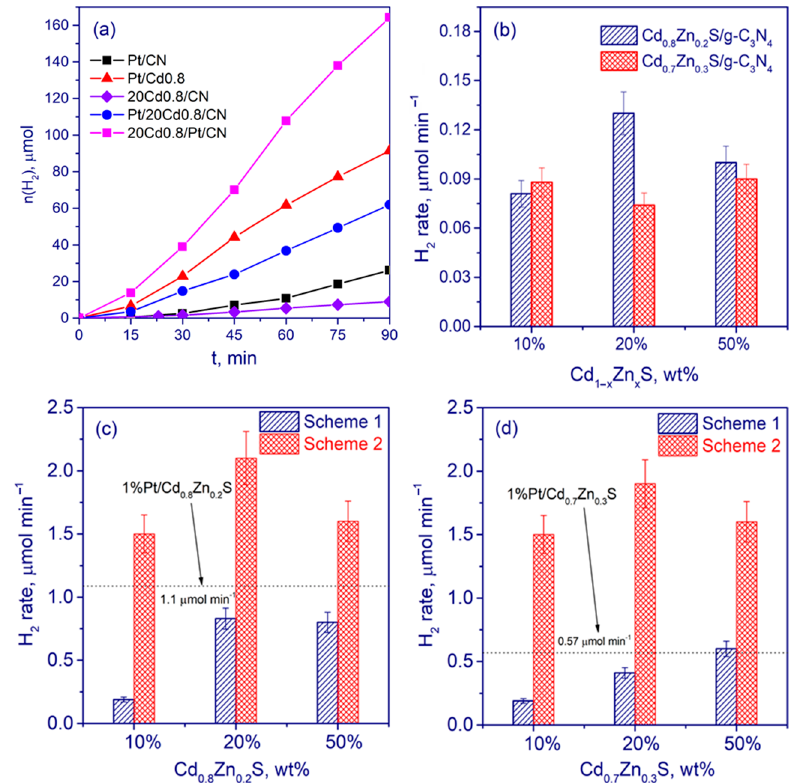
Figure 6. Kinetic curves of the photocatalytic hydrogen evolution over selected photocatalysts ( a ); comparative data on hydrogen production over composite photocatalysts Cd 1-x Zn x S/g-C 3 N 4 (x = 0.2– 0.3) ( b ) and ternary systems 1%Pt/Cd 1-x Zn x S/g-C 3 N 4 (Scheme 1) or Cd 1-x Zn x S/1%Pt/g-C 3 N 4 (Scheme 2) (x = 0.2 ( c ); x = 0.3 ( d )). Conditions: C 0 (NaOH) = 0.1 M, C 0 (TEOA) = 10 vol%, C cat = 0.5 g L − 1 ; LED light source ( λ = 450 nm).